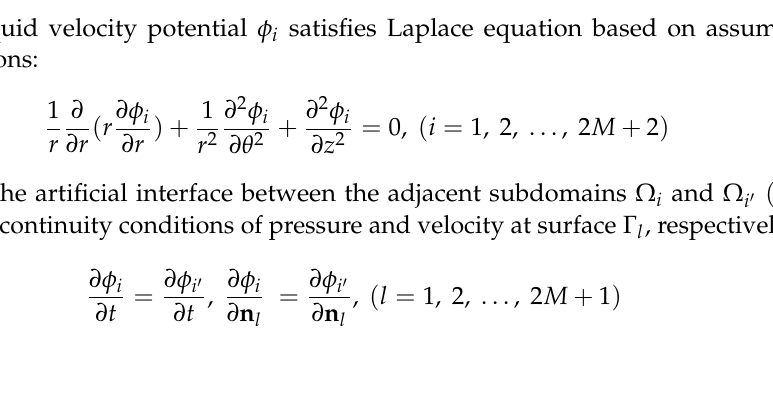
Figure 2. Artificial surfaces and liquid subdomains.